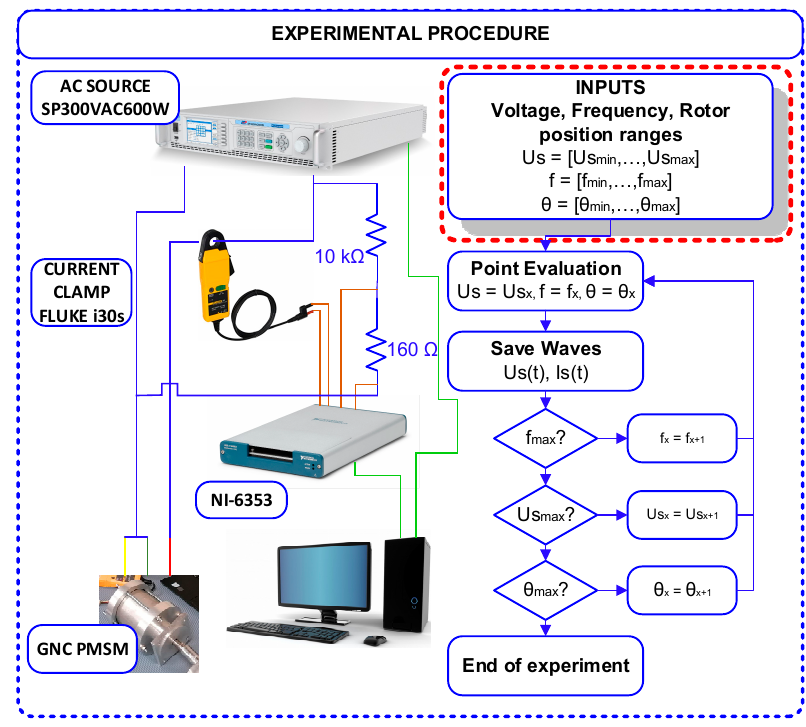
Figure 1. Experimental setup and test procedure.